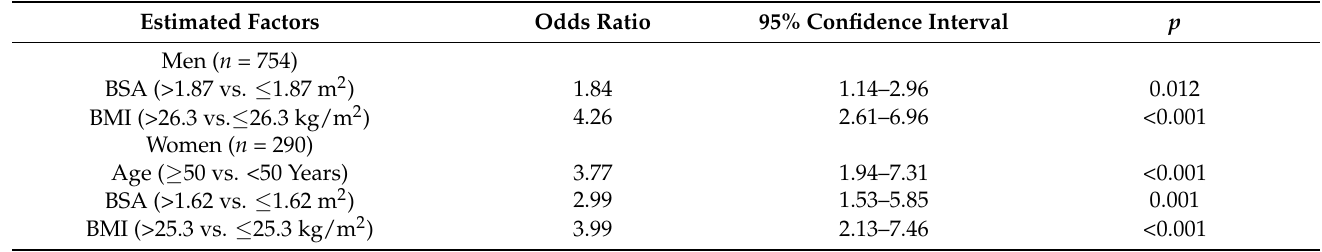
Table 4. Multivariable analysis of risk factors for visceral obesity in Chinese adults with high BMI ( n =